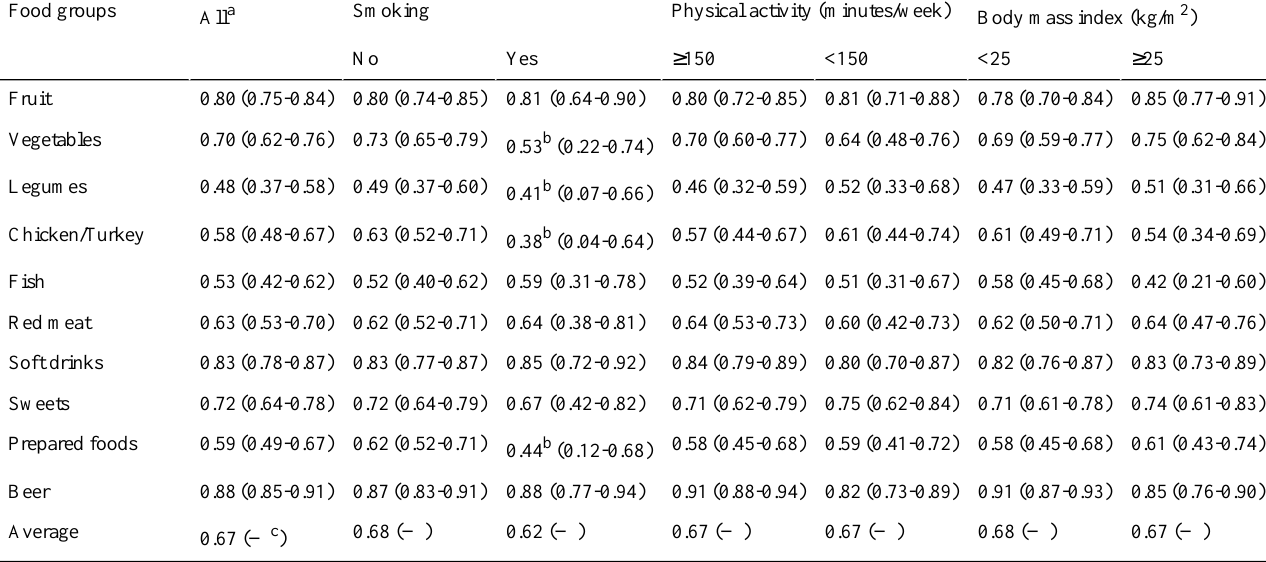
Table 3. Spearman correlation coefficients derived from the electronic 12-hour dietary recall app versus the food frequency questionnaire for categories of food group consumption and strata: smoking: no and yes; physical activity (minutes/week): ≥ 150 and <150; and body mass index (kg/m 2 ): <25 and ≥ 25. Comparison of the electronic 12-hour dietary recall app versus food frequency questionnaire. Spearman correlation coefficients (95%